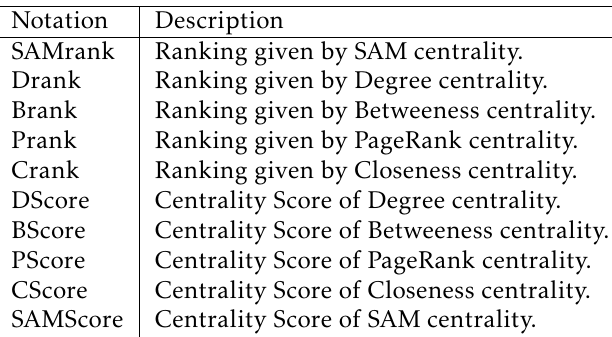
Table 1. Notations Used in Results